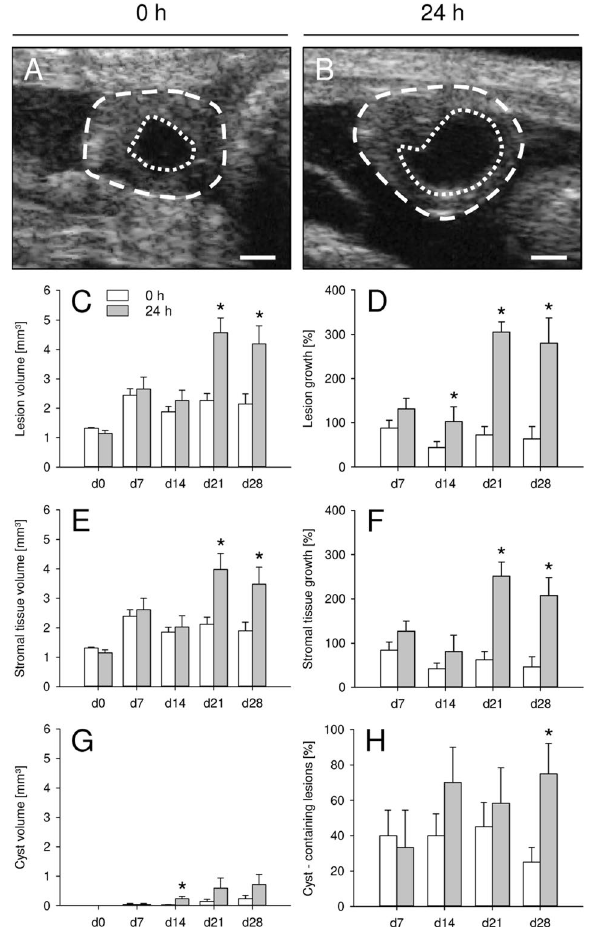
Figure 4. ( A , B ) High-resolution ultrasound imaging of endometriotic lesions (broken lines = borders, dotted lines = cyst-like dilated endometrial glands) on day 28 after transplantation of freshly isolated (0 h; A ) and 24-h-precultivated ( B ) uterine tissue samples from C57BL/6-TgN(ACTB-EGFP)1Osb/J donor mice to the peritoneal wall of C57BL/6J recipient mice. Scale bars: 500 µm. ( C – H ) Overall lesion volume ( C , mm 3 ), lesion growth ( D , %), stromal tissue volume ( E , mm 3 ), stromal tissue growth ( F , %), cyst volume ( G , mm 3 ) and cyst- containing lesions ( H , %) of endometriotic lesions directly after transplantation (d0) as well as on days 7, 14, 21 and 28 after transplantation of freshly isolated (0 h; white bars; n = 10) and 24-h-precultivated (grey bars; n = 6) uterine tissue samples from C57BL/6-TgN (ACTB-EGFP)1Osb/J donor mice to the peritoneal wall of C57BL/6J recipient mice. Mean ± SEM; *P < 0.05 vs. 0